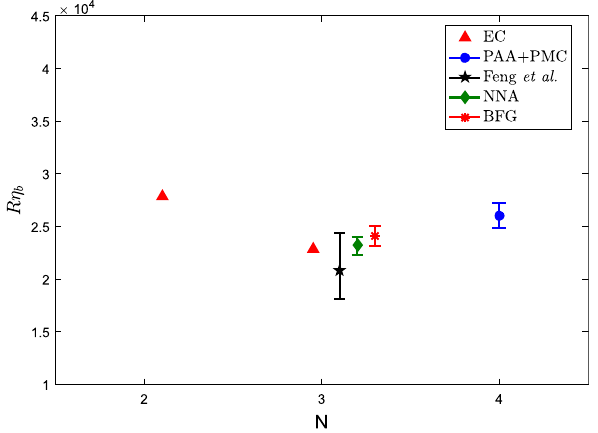
Fig. 4 The R η -ratio under various approaches. “EC” is the exact b prediction by using the known NLO or NNLO PMC series, and “PAA+PMC” is the PAA prediction by using the PMC NNLO series. The error of “PAA+PMC” at the NNNLO level (N=4) is caused by (cid:5)α ( M 2 ) = ± 0 . 0011. As comparisons, the NNLO predictions (N=3) s Z of Feng et al. [10], NNA [11] and BFG [11] are also